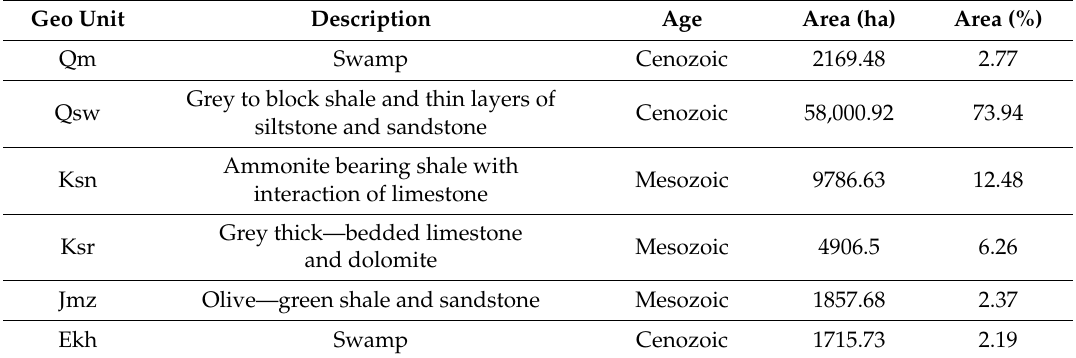
Table 2. Lithology of the study